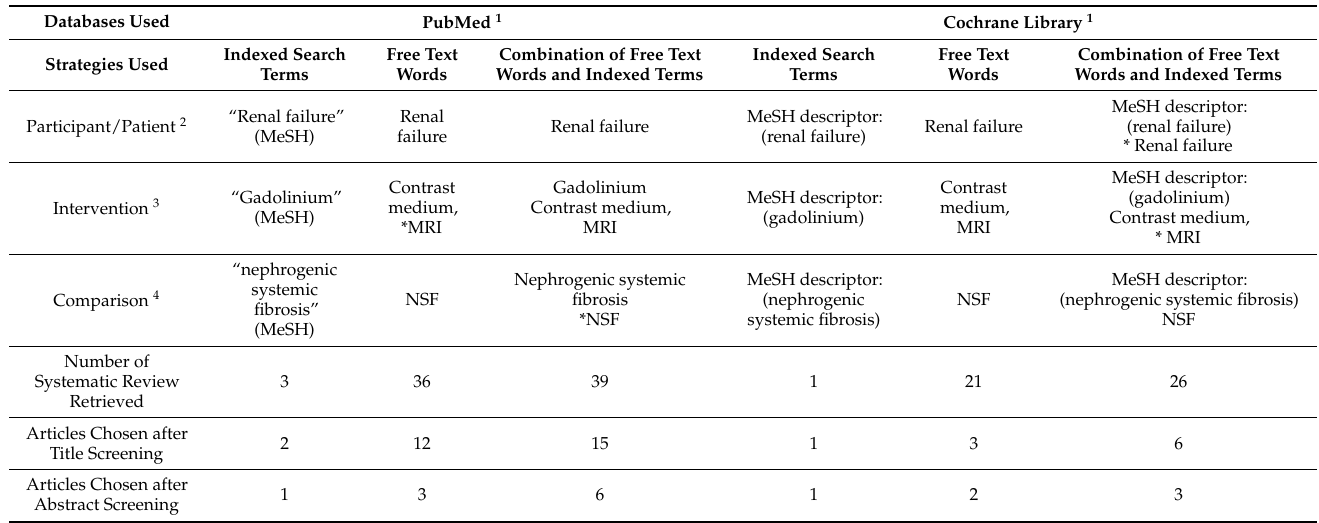
Table 2. Terms used in the search.